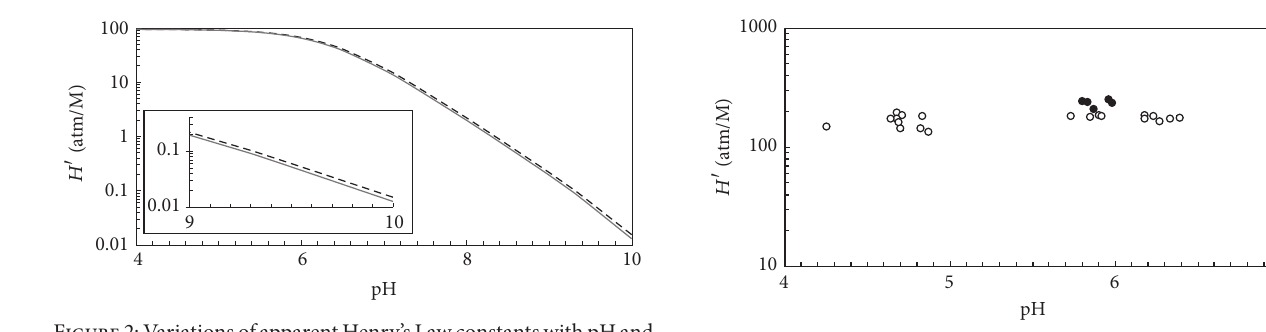
Figure2:VariationsofapparentHenry’sLawconstantswithpHand 3∗ = 1.5 mg/L (solid = 1500 ppm and H temperature for CO 2( 2 CO g ) line indicates 25 ∘ C and dash line indicates 35 ∘ C). Figure 3: Variations of apparent Henry’s Law constants with pH at different water